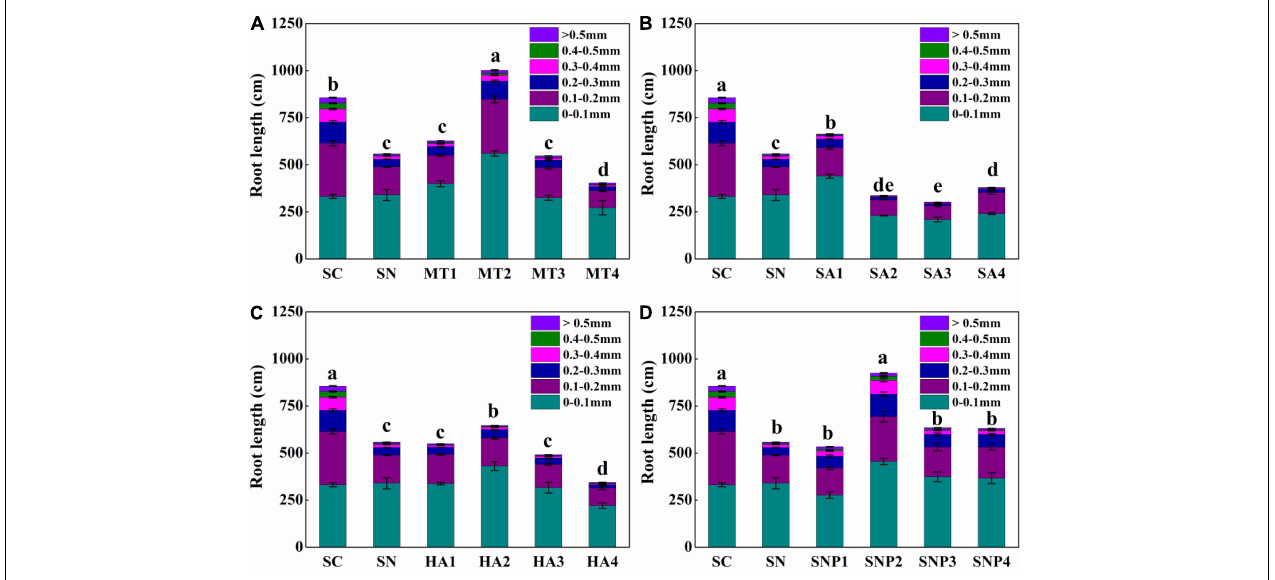
FIGURE 5 | Root-length proportions of sections with different diameters in response to high-nitrate stress of (A) MT, (B) SA, (C) HA, and (D) SNP application treatment. SC, control; SN, high-nitrate stress treatment; MT, melatonin; SA, salicylic acid; HA, humic acid; SNP, sodium nitroprusside; MT1–4